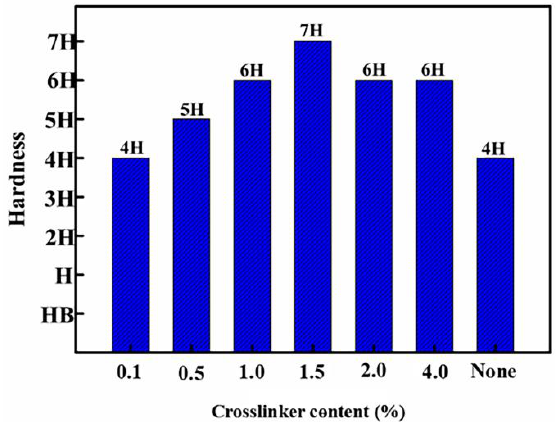
Figure 8. Hardness diagram of coating with different crosslinking agent content.